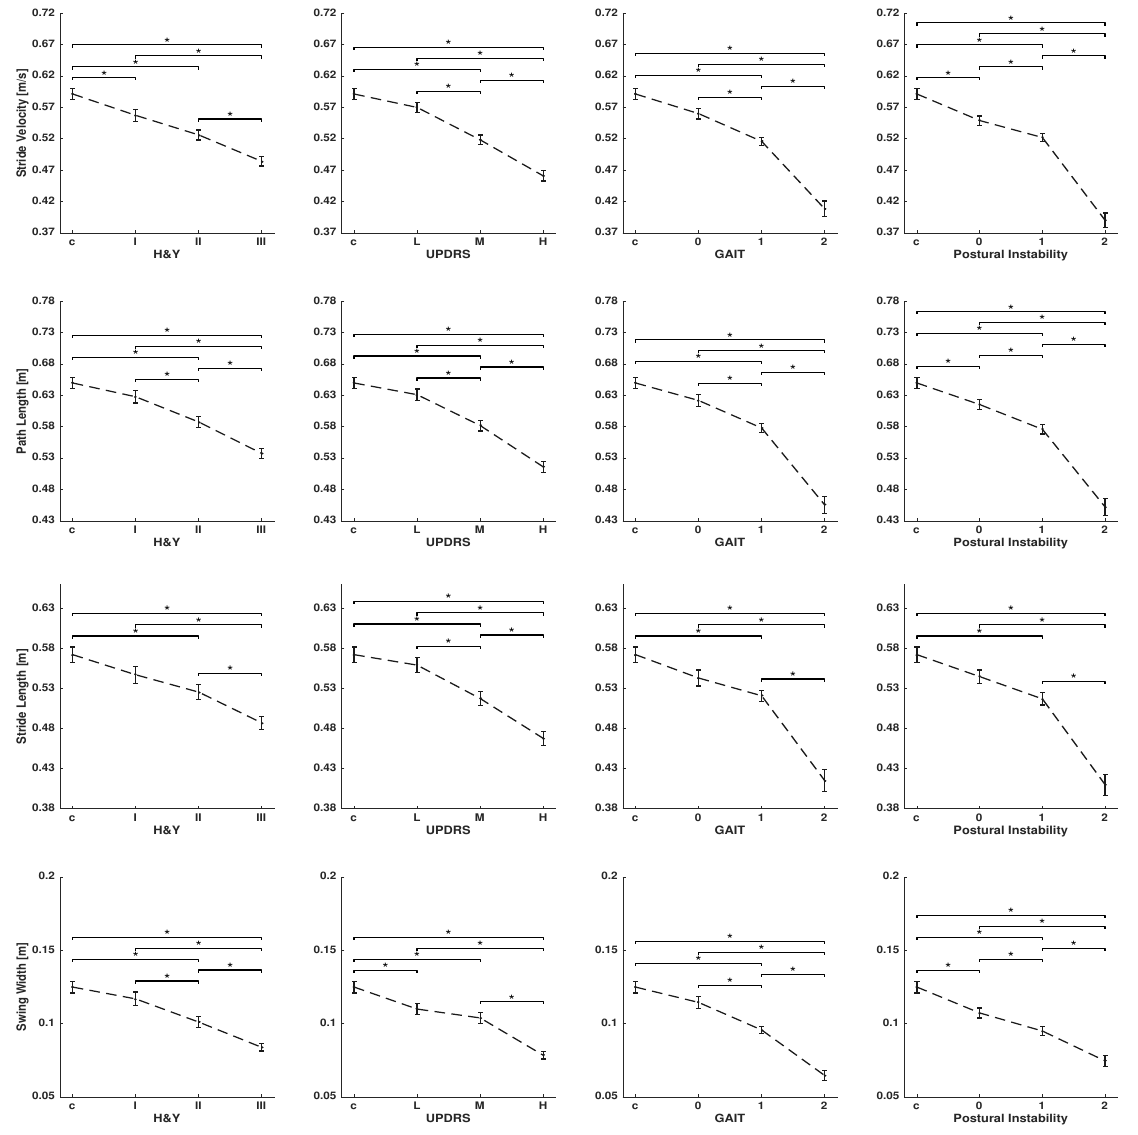
Figure 3. Per-stride parameters characterizing turning: stride velocity, path length, stride length, and swing width were calculated for controls and PD patients who were grouped according to the H&Y disease stage, UPDRS-III score, and the single items, gait and postural instability, of the UPDRS-III. Group data are displayed as mean ± SEM and were compared using one-way ANOVA, followed by Bonferroni’s post hoc test, where * indicates p <